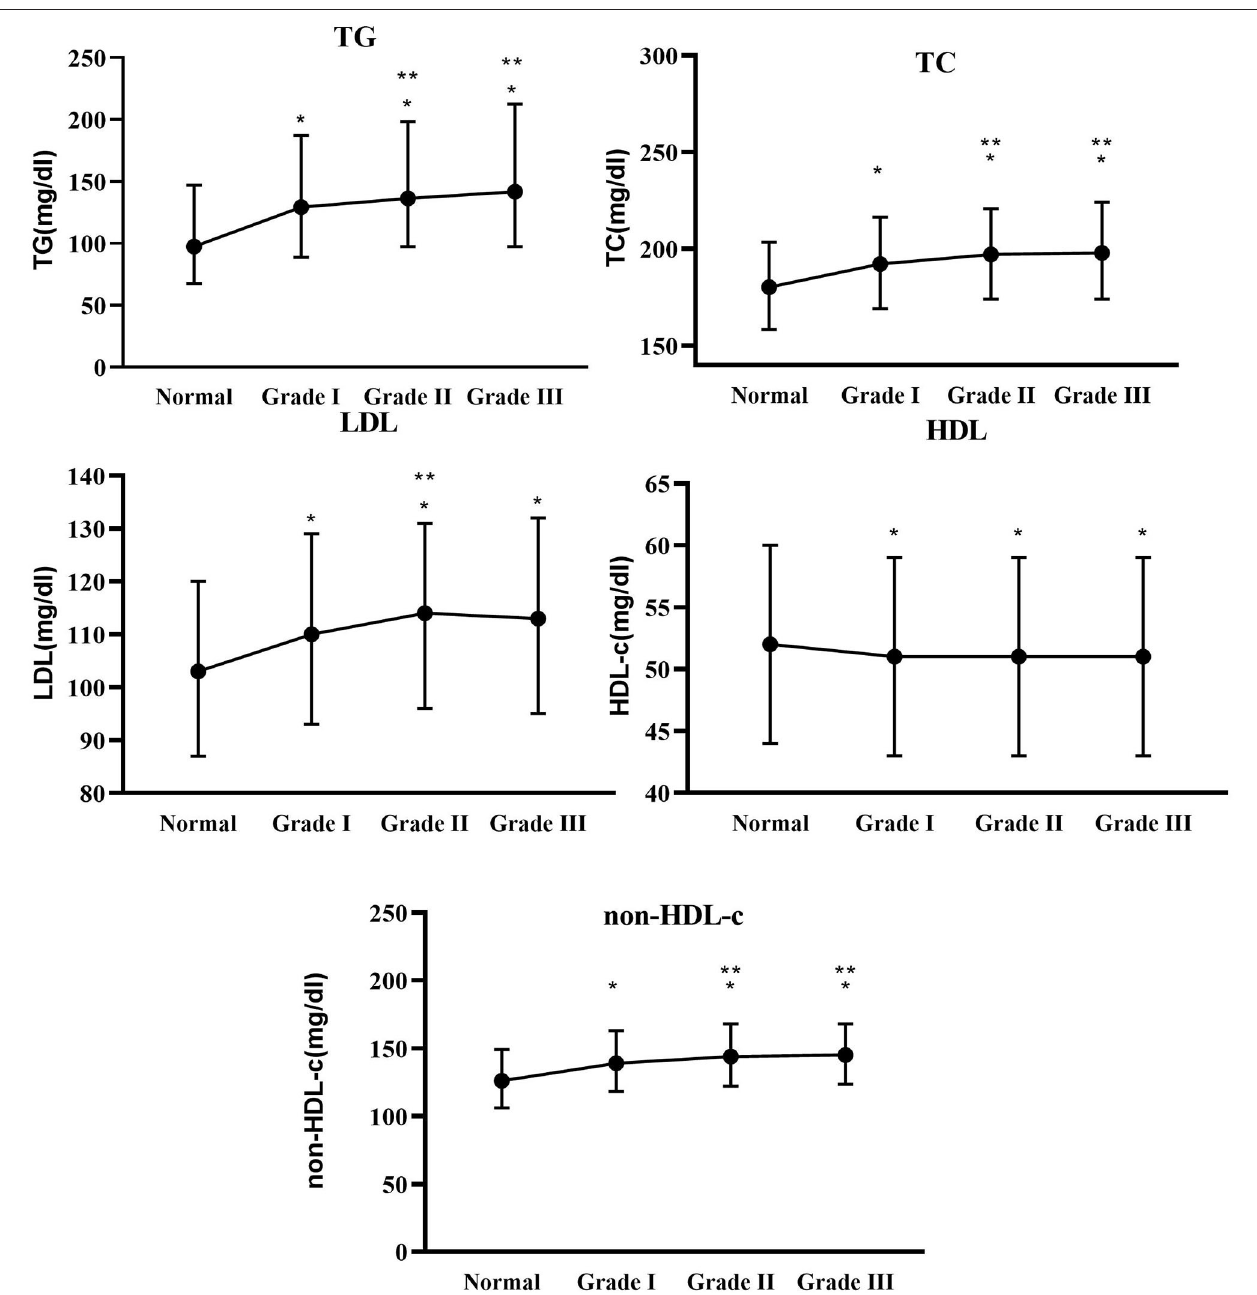
FIGURE 2 | Between-group differences in total cholesterol (TC), TG, low-density lipoprotein (LDL), high-density lipoprotein cholesterol (HDL-c), and non-HDL-c at different blood pressure levels. * Indicates Grades I–III compared with the normal group with p < 0.05. ** Indicates Grades II and III compared with Grade I with p <